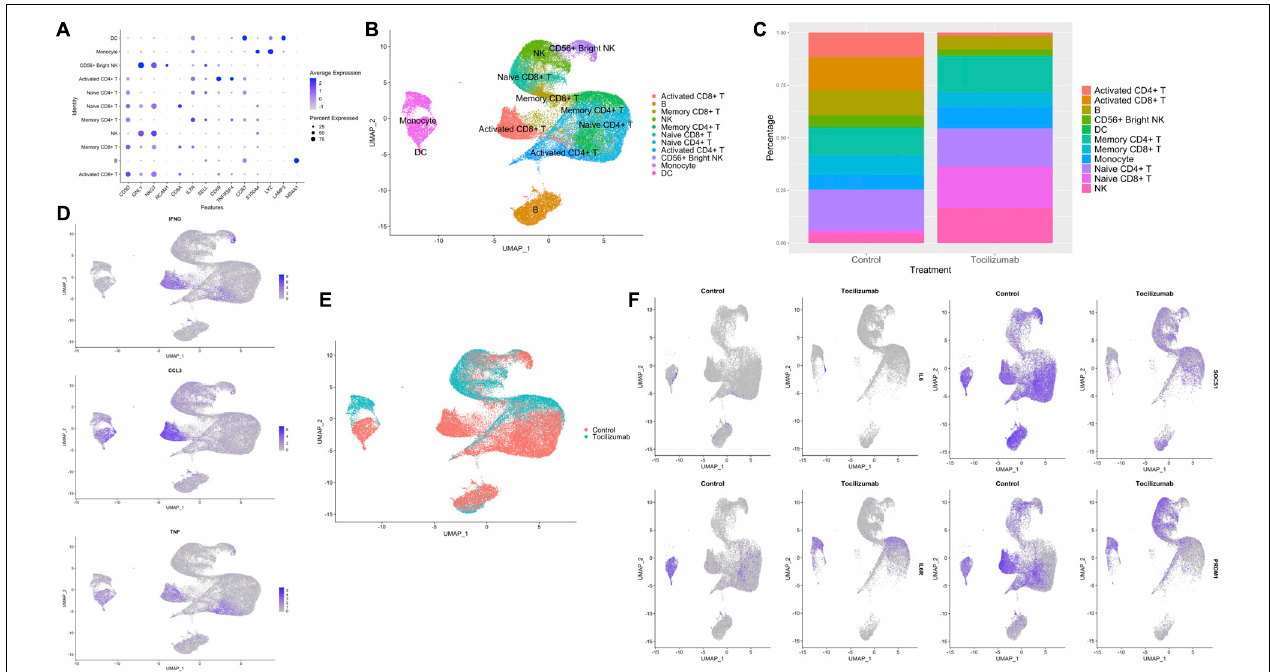
FIGURE 2 | UMAP projections, cell subset annotation, and expression of inflammatory markers and IL6R pathway genes in control vs. Tocilizumab-treated PBMCs. (A) Dot plot of canonical markers used for annotation of the 20 cell clusters. Average feature expression represented by color gradient with lower expression represented by light gray, and higher expression represented by blue. Size of dots represent the percent of cells within that specific cluster that express the feature of interest. (B) UMAP with final cell type annotations. (C) Bar plot showing the percentage of each cell type in control vs. Tocilizumab-treated groups. (D) Feature plots showing expression of select cytokines involved in SARS-CoV-2 cytokine storm ( IFNG , CCL3 , and TNF ) based on control vs. Tocilizumab treatment status. Feature expression represented by color gradient, with high expression represented by blue and low expression represented by gray. (E) UMAP with cell clusters identified based on control vs. Tocilizumab treatment status. (F) Feature plots showing expression of IL6 , IL6R , and downstream IL6R pathway genes ( SOCS1, PRDM1 ) based on control vs. Tocilizumab treatment status. Feature expression represented by color gradient, with high expression represented by blue and low expression represented by